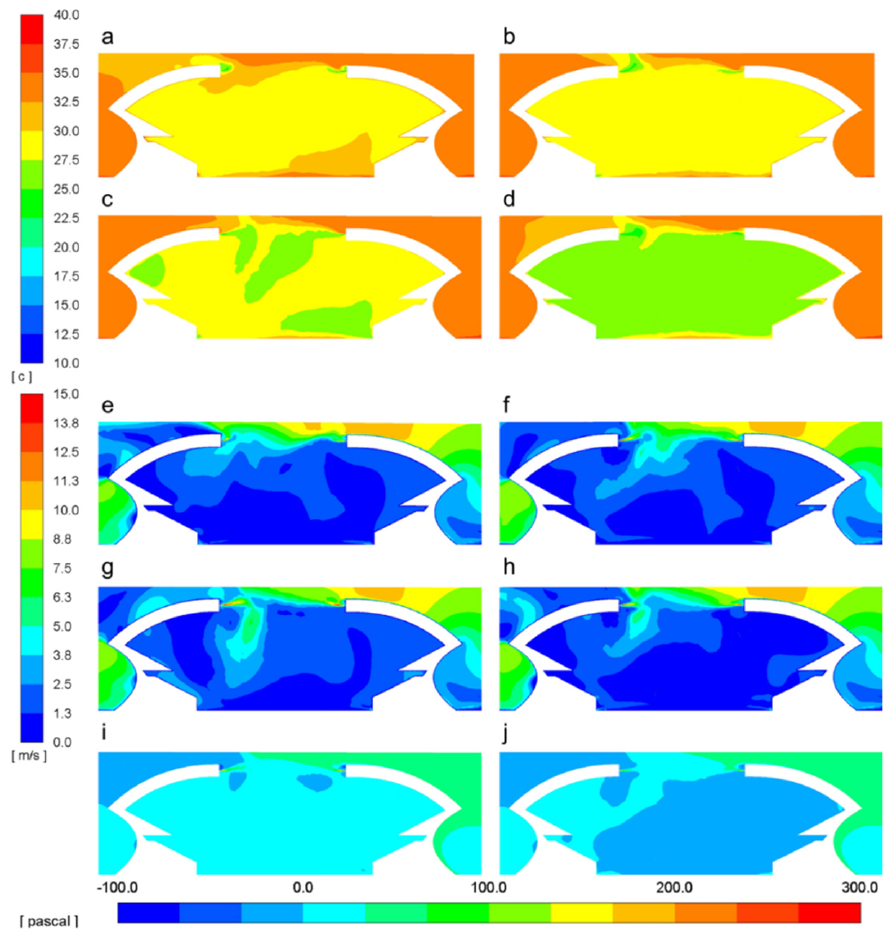
Figure 10. ( a – d ) Temperature contours of the cross-section of the stadium for scenarios one to four. ( e – h ) Wind velocity contours of the cross-section of the stadium for scenarios one to four. ( i , j ) Total pressure contours of the cross-section of the stadium for scenarios three to four.